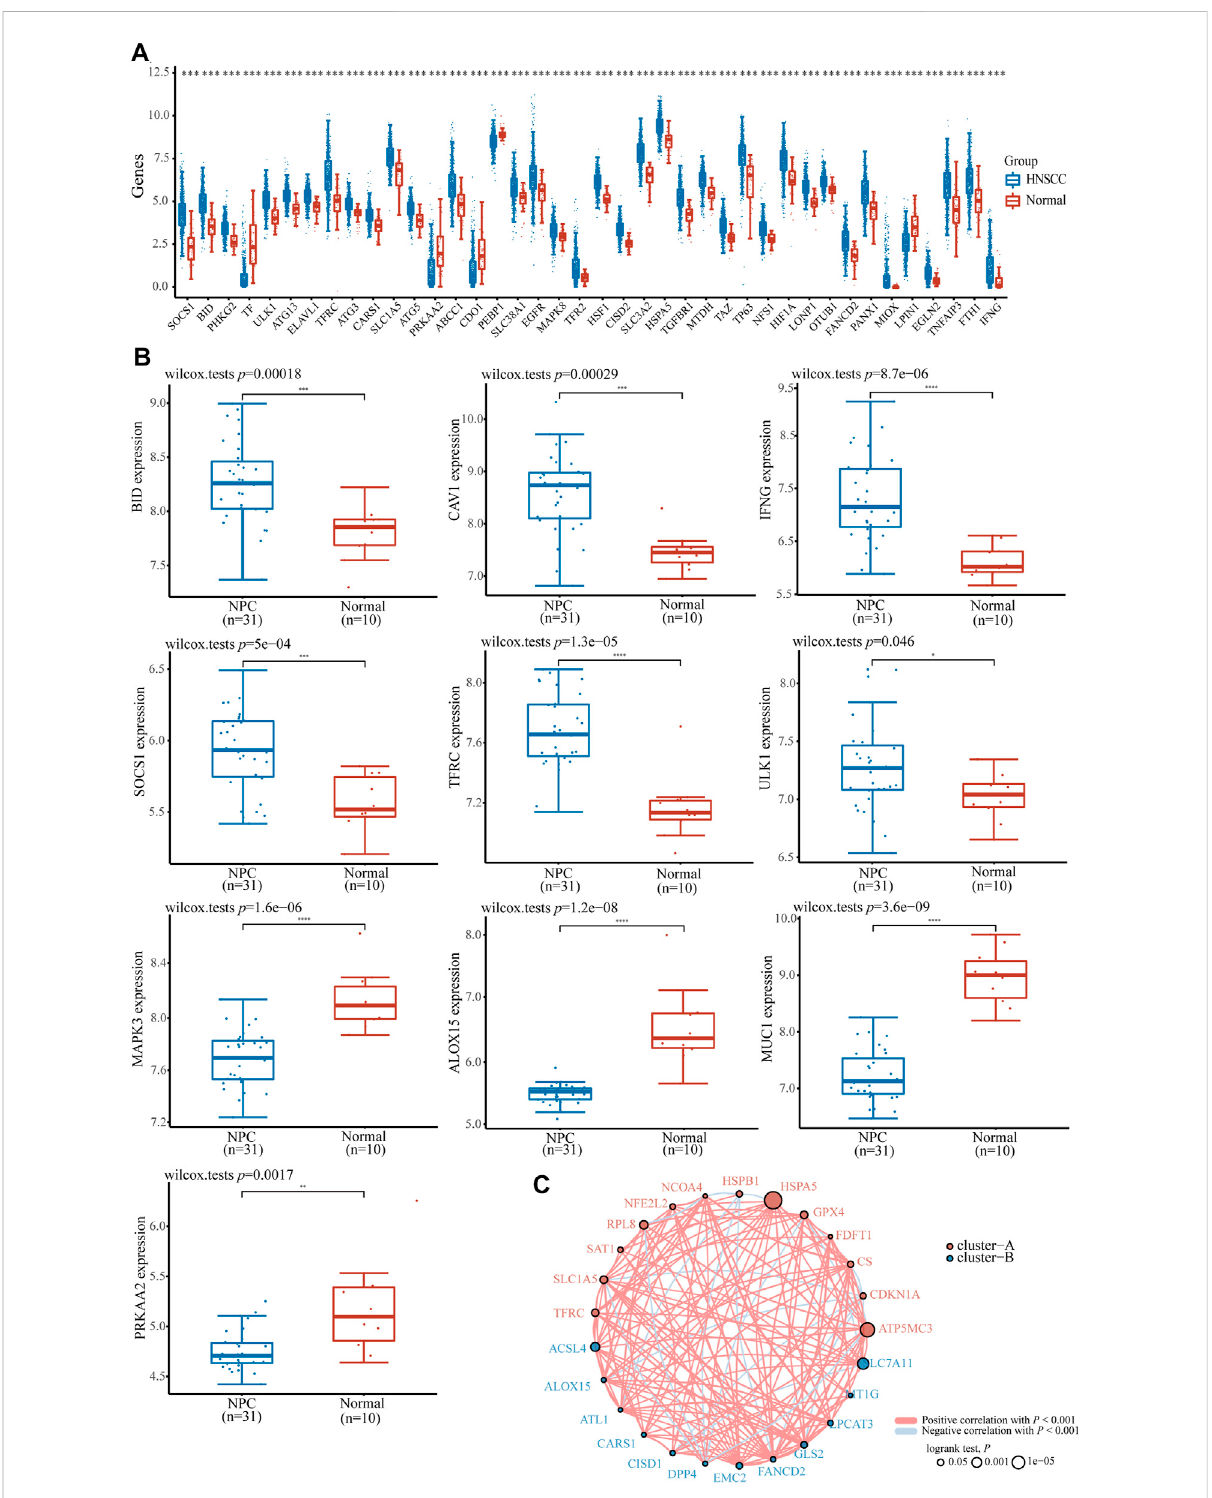
FIGURE 1 Theexpressiondistributionofferroptosis-relatedgeneinHNSCCandNPCpatients. (A) ferroptosis-relatedgeneinHNSCCandnormalsamples baseonTCGAHNSCCdataset. (B) Theexpressiondistributionofferroptosis-relatedgeneinNPCandnormalsamplesbaseonGSE12452dataset. (C) The correlation of ferroptosis-related gene in HNSCC samples, circles represent the ferroptosis-related gene, red and blue represent positive and negative correlation between each gene, the size of the circle represent log rank p . * p < 0.05, ** p < 0.01, *** p <